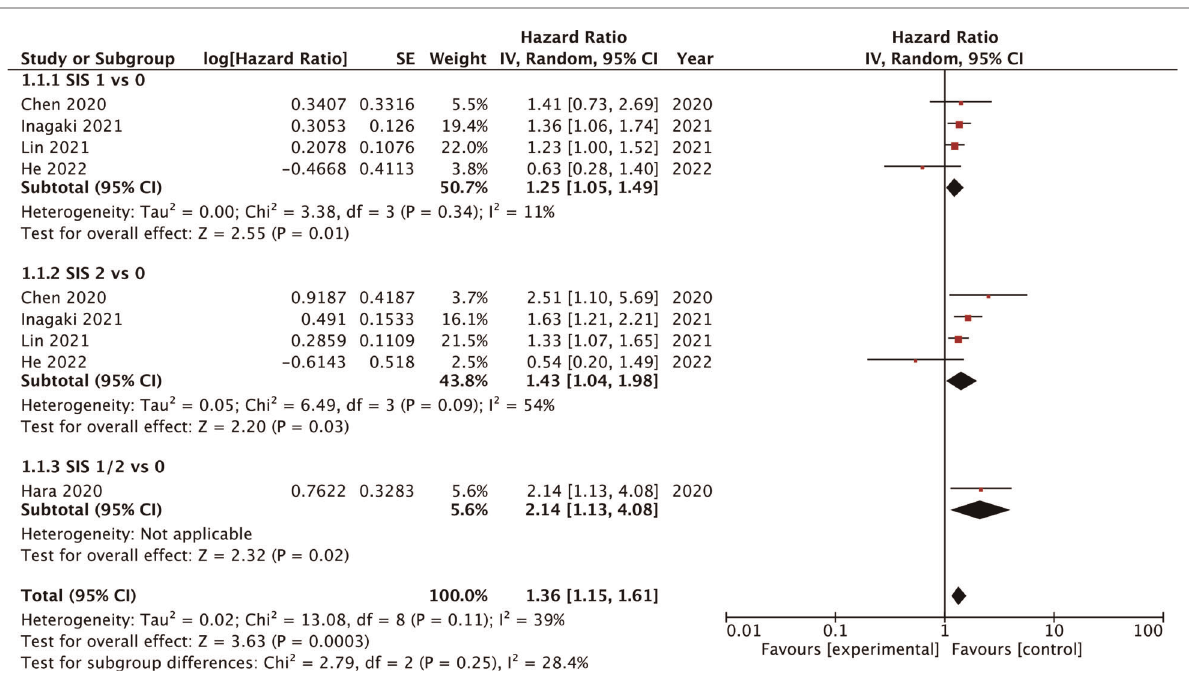
FIGURE 3 Meta-analysis of the association between SIS score and OS in gastric cancer patients with subgroup analysis based on different reference SIS score (1 vs. 0, 2 vs. 0, or 1 – 2 vs. 0). Blue boxes indicate the point estimates of individual studies and horizontal lines denote the con fi dence intervals. Black diamond indicates the total effect size.